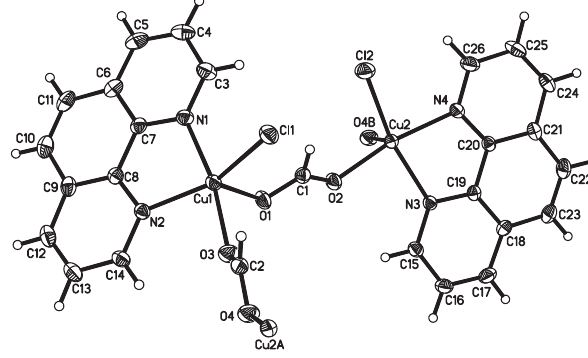
Table 1: Data collection and handling.